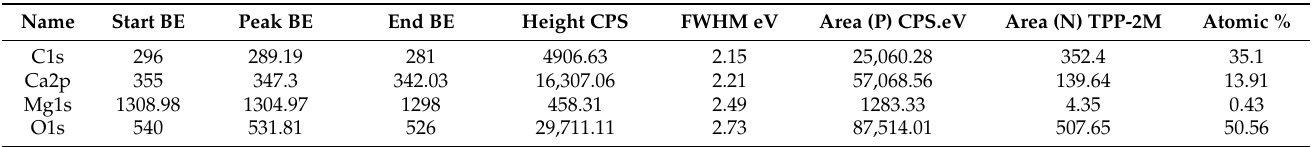
Figure 8. ( a ) XPS spectra of different elements of CaMg(CO 3 ) 2 , dolomite nanoparticles. ( b ) Calcium’s 2p3/2 and 2p1/2 core levels spectra of nanoparticles. ( c ) CO 32 − and C=O levels spectra of thick film. ( d ) CxHy and CO 32 − . ( e ) MgCO 3 in binding energy. ( e ) Survey spectra of the prepared sample. Abbreviations: XPS for X-ray Photoelectron Spectroscopy. Table 1. SR-XPS C1s, Ca2p, Mg1s, O1s S2p core levels data collected on thick film of pure CaMg(CO 3 ) 2 nanoparticle stabilized by BE, FWHM, atomic ratio, and